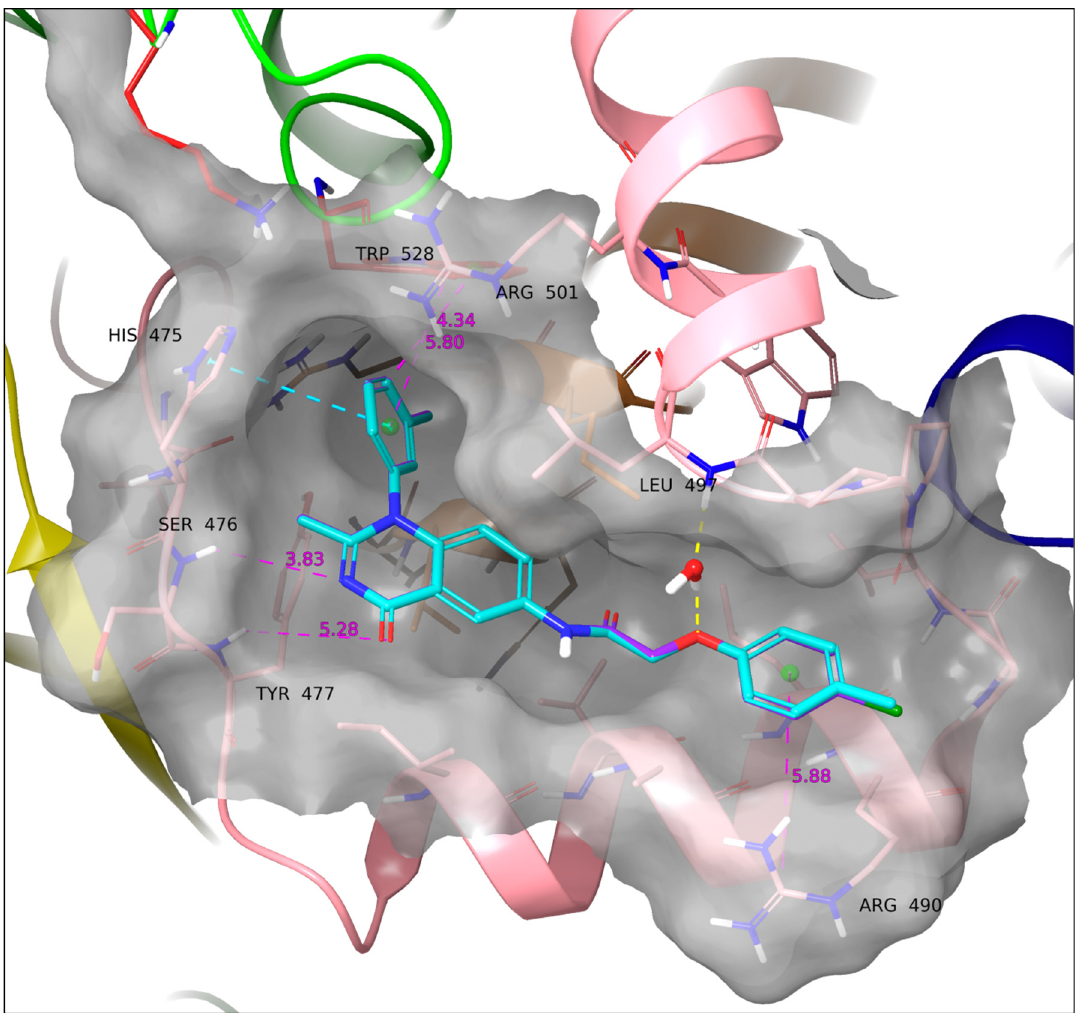
Figure 9. Docking poses of 11d (cyan) and 11e (purple). The two ligands have an identical binding mode. A water bridge with Leu497 and a sandwich π – π stacking with His475 are formed. Yellow dotted line: Hydrogen bond. Cyan dotted line: π – π interaction. All the above SARs were identified employing the default settings of Maestro. Violet dotted line and number: Atom/ring distance in Å (measured manually).